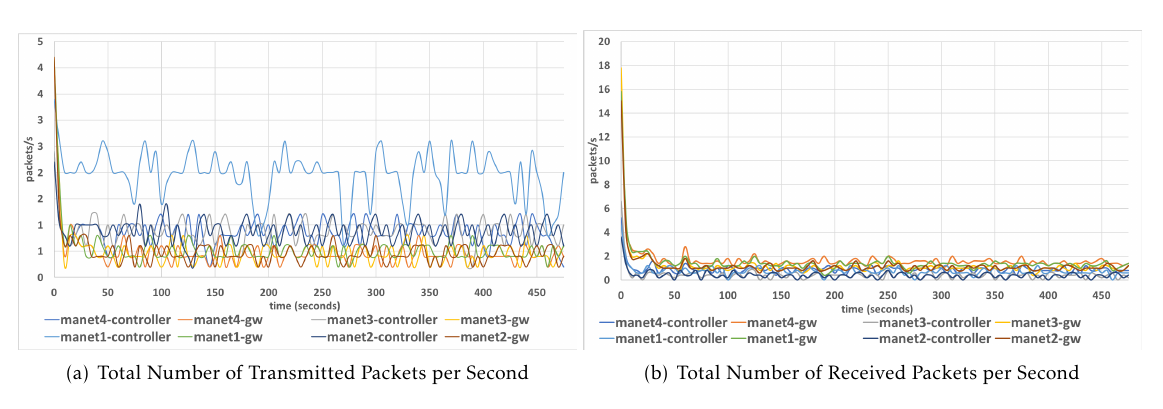
Figure 11. Unit Assignment - Assigning an Edge Node to the Networks